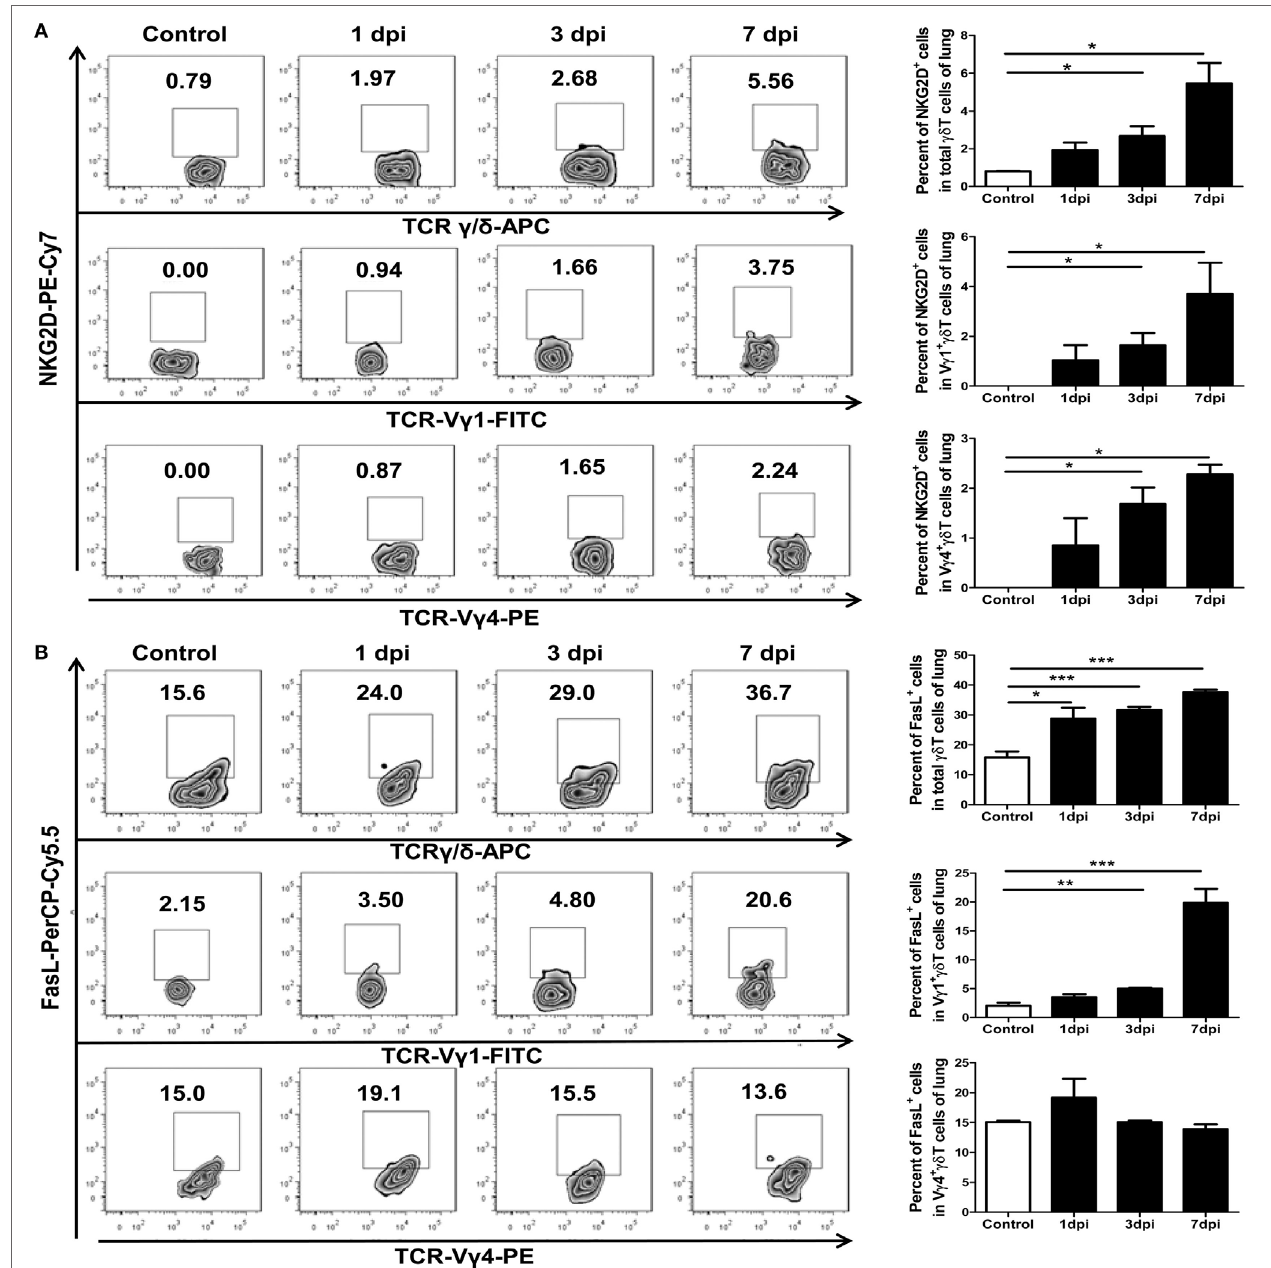
FigUre 6 | Influenza A (H1N1) pdm09 infection-induced expression of NKG2D and FasL in γδ T cells and the V γ 1 + γδ T or V γ 4 + γδ T subset in the lungs at different dpi. Expression of NKG2D (a) and FasL (B) by γδ T cells (upper, gated on CD3 + T cells) and V γ 1 + γδ T (middle, gated on CD3 + γδ TCR + cells) or V γ 4 + γδ T (lower, gated on CD3 + γδ TCR + cells) subsets was measured using flow cytometry. The numbers represent the proportion of NKG2D- or FasL-positive cells among the different subsets at the indicated dpi. Histogram showing the statistical analysis of the proportion of NKG2D + or FasL + cells in the different subsets in the control or infected lungs at different dpi. The results are representative of two independent analyses ( n = 3 for each group). * p < 0.05, ** p < 0.01, *** p <